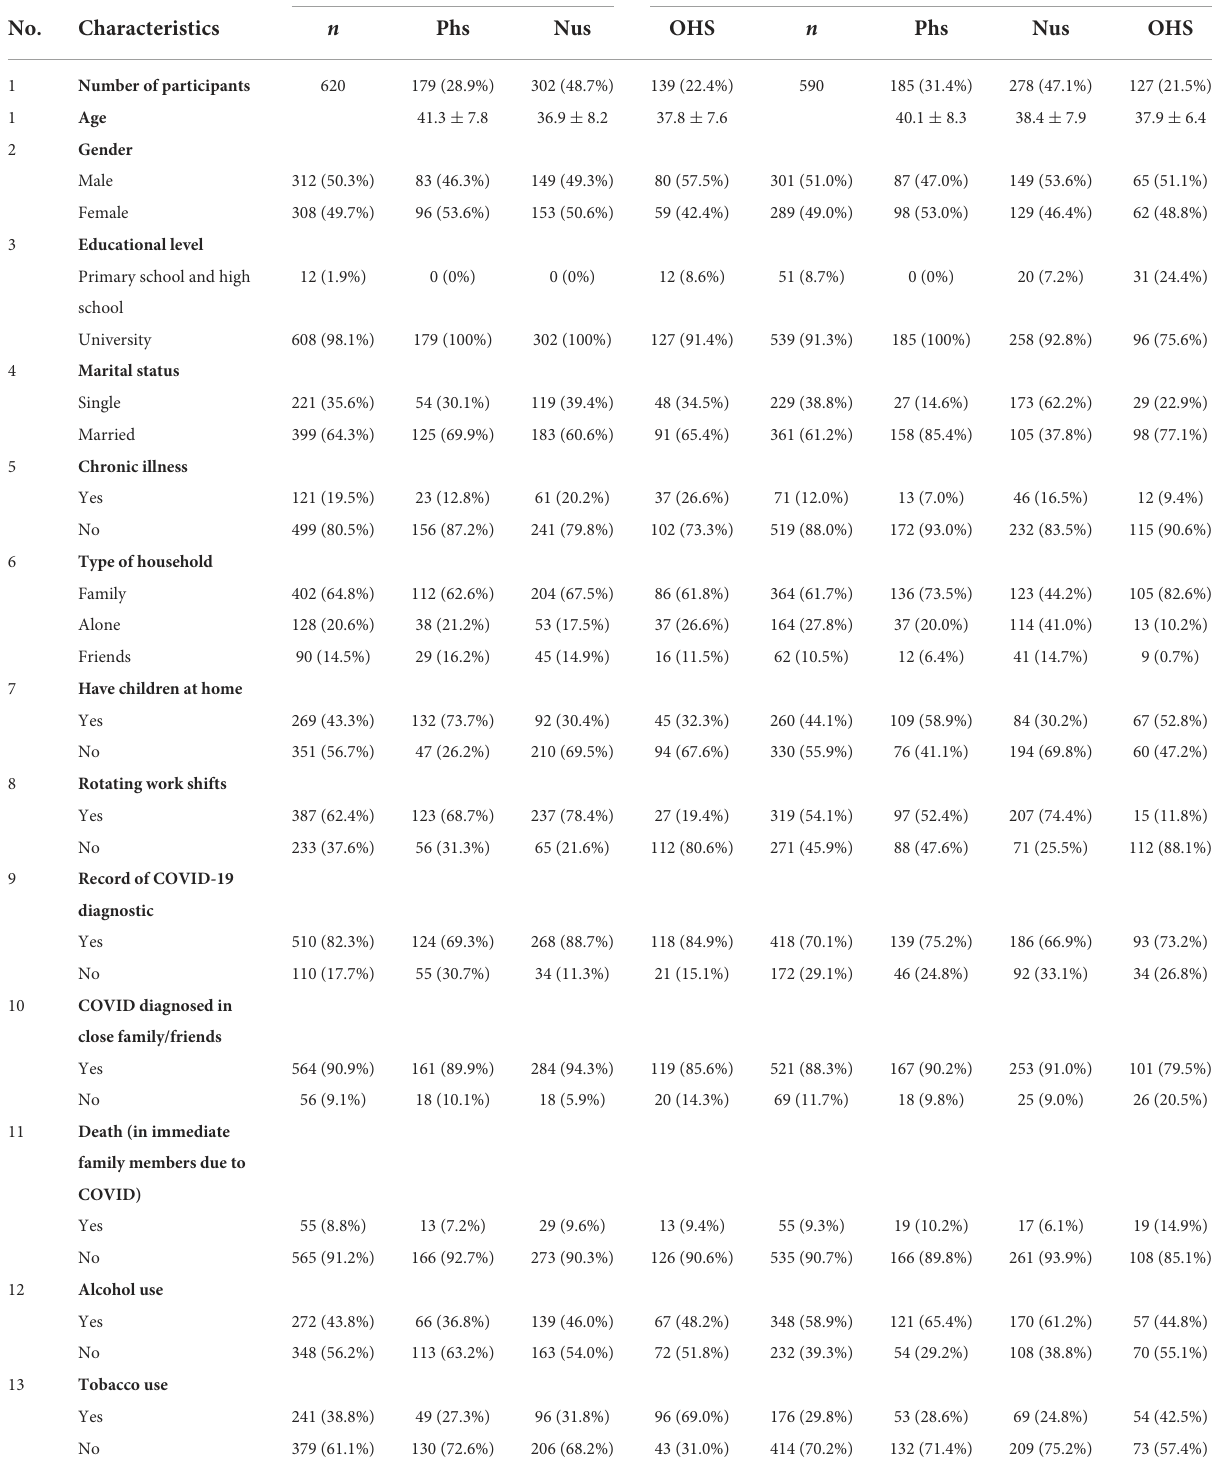
TABLE 2 Sociodemographic, medical, and work-related characteristics of the participants in the present study. Iran The studied European